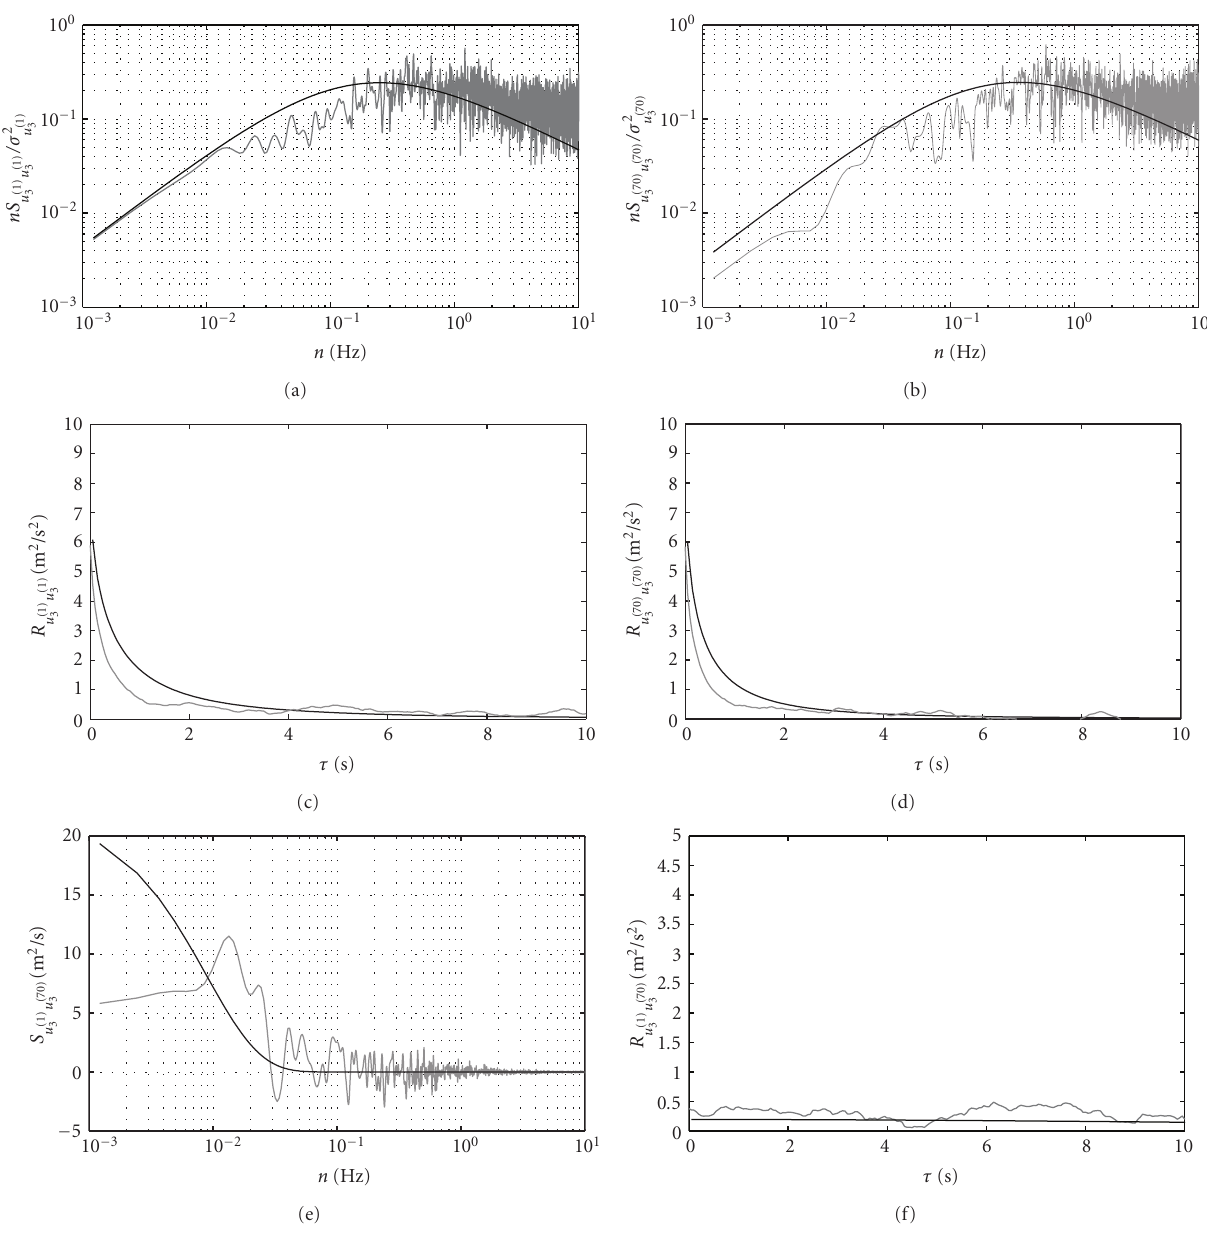
Figure 14: Example 2 using AR method (black lines denote target functions, gray lines denote numeric approximations): auto-spectra of across-wind velocities at points 1 and 70 (a), (b); corresponding autocorrelation functions (c), (d); cross-spectrum between along-wind velocities at points 1 and 70 (e); corresponding cross-correlation function